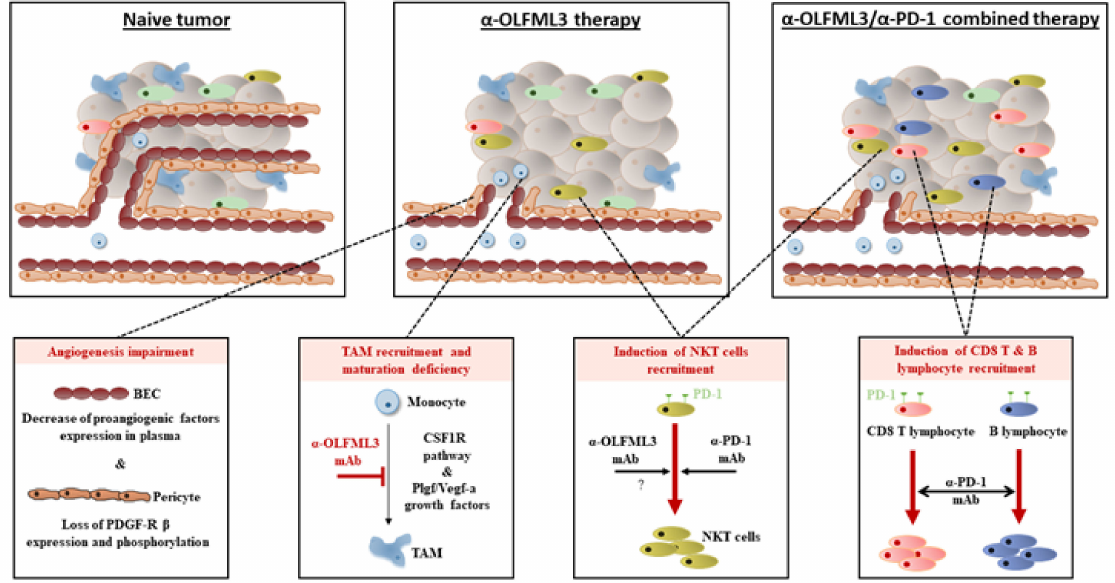
Figure 7. Proposed model illustrating the antitumor effect of anti-OLFML3 antibody treatment alone and in combination with anti-PD-1 checkpoint inhibitors. In naïve tumors, a high number of intratumoral blood vessels and pericytes are observed. Tumors are rich in tumor-associated macrophages but are poorly infiltrated by T, B, and NKT lymphocytes. Targeting of OLFML3 reduces the number of blood vessels, pericytes, and TAMs and increases the number of NKT cells. When combined with an anti-PD-1 checkpoint inhibitor, anti-OLFML3 treatment increases tumor infiltration by B lymphocytes and increases infiltration by NKT lymphocytes. Together, these effects inhibit tumor